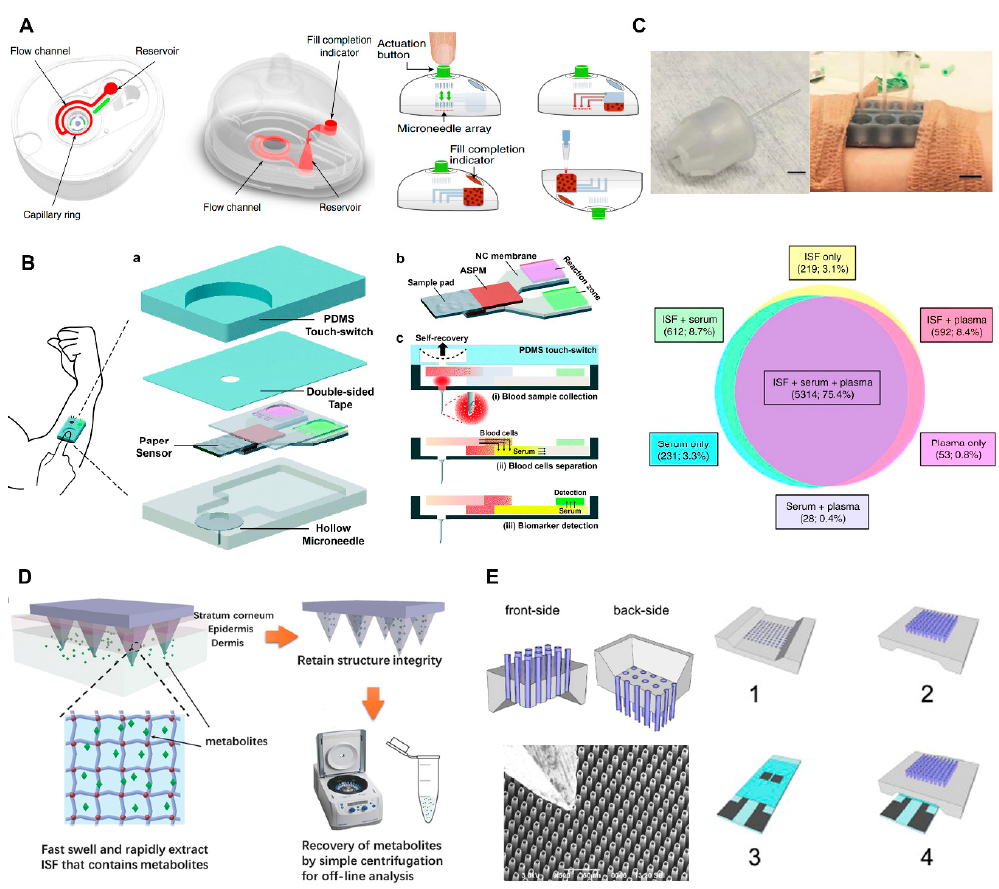
Figure 6. ( A ) Schematic illustration of a self-powered one-touch blood collector (left) and collection steps (right) (reproduced with permission from the authors of [34] ). ( B ) Schematic illustration of one-touch-activated blood multi-diagnostic system. (reproduced with permission from the authors of [131]). ASPM, asymmetric polysulfone membrane; NC, nitrocellulose. ( C ) Hollow MN-based ISF collector (top-left) and MN holders attached to skin for ISF extraction (middle-left) and similarity of RNA species detected in ISF, serum, and plasma samples (down) (reproduced with permission from the authors of [133] ). ( D ) Schematic of MeHA swellable MN designed for ISF collection (reproduced with permission from the authors of [17] ). ( E ) Schematic illustration of silicon hollow MN-based ISF collector and its scanning electron microscope (SEM) image. Schematic illustrations including the front-side (1), back-side (2) of MN chip, real-time glucose measurement chip (3), and usage of the two chips (4) (right) (reproduced with permission from the authors of [34] ).